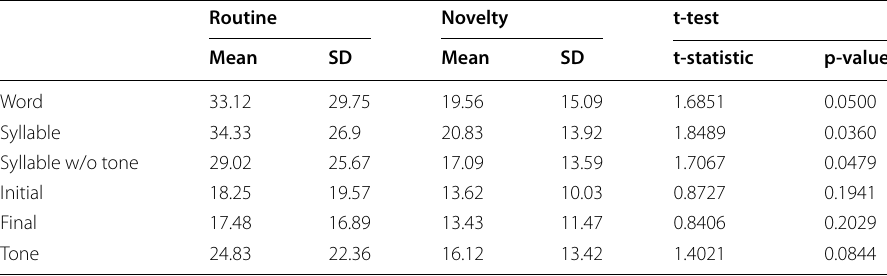
Table 2 Pretest-delayed posttest improvements among beginning learners Routine